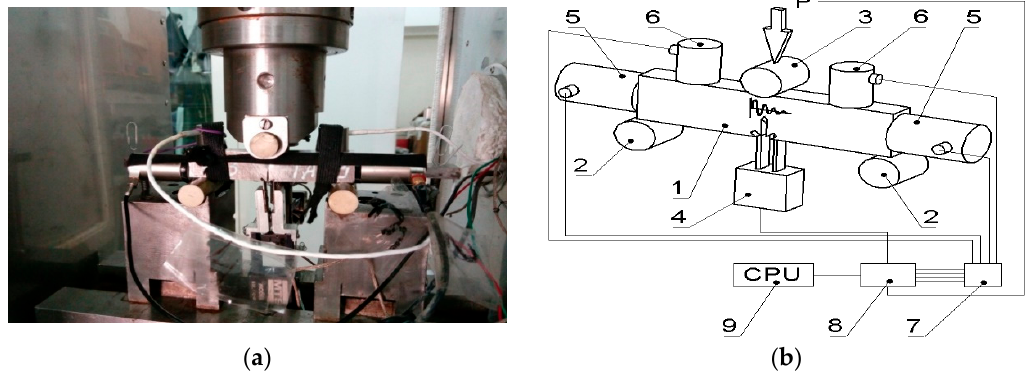
Figure 1. The SENB specimen in three-point bending with installed AE sensors: ( a ) photograph of the specimen in the thermal chamber; ( b ) scheme of loading and installation of mechanical and AE sensors.